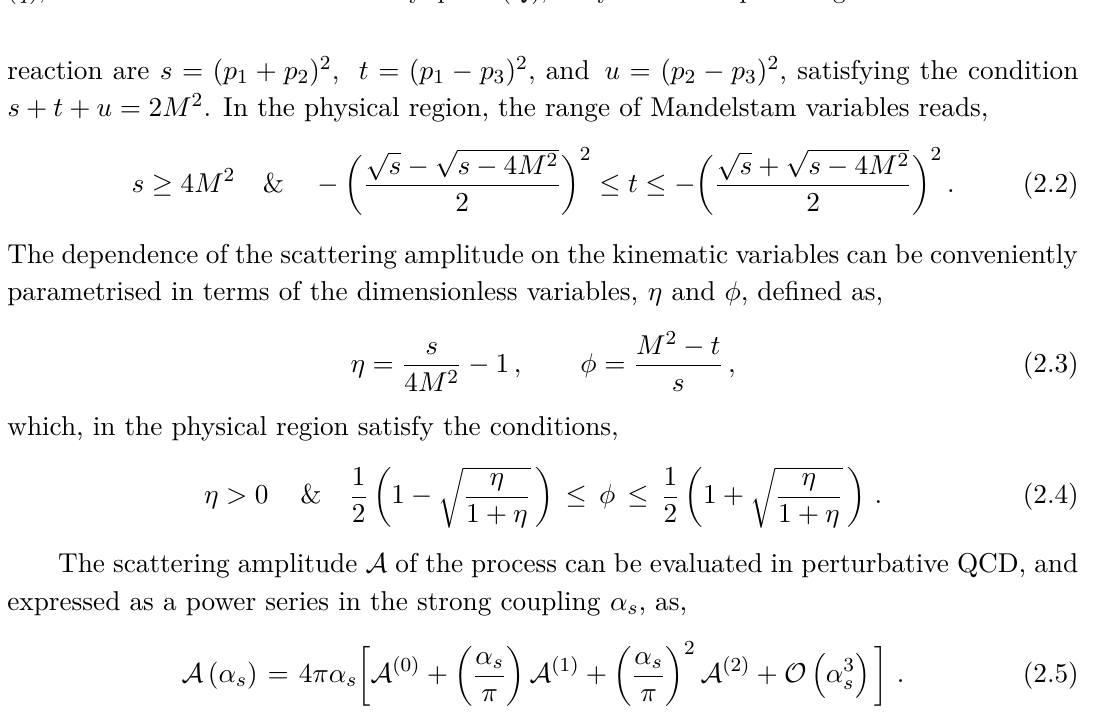
+ p ) 2 , t = ( p ) 2 , and u = ( p − p 1 2 1 3